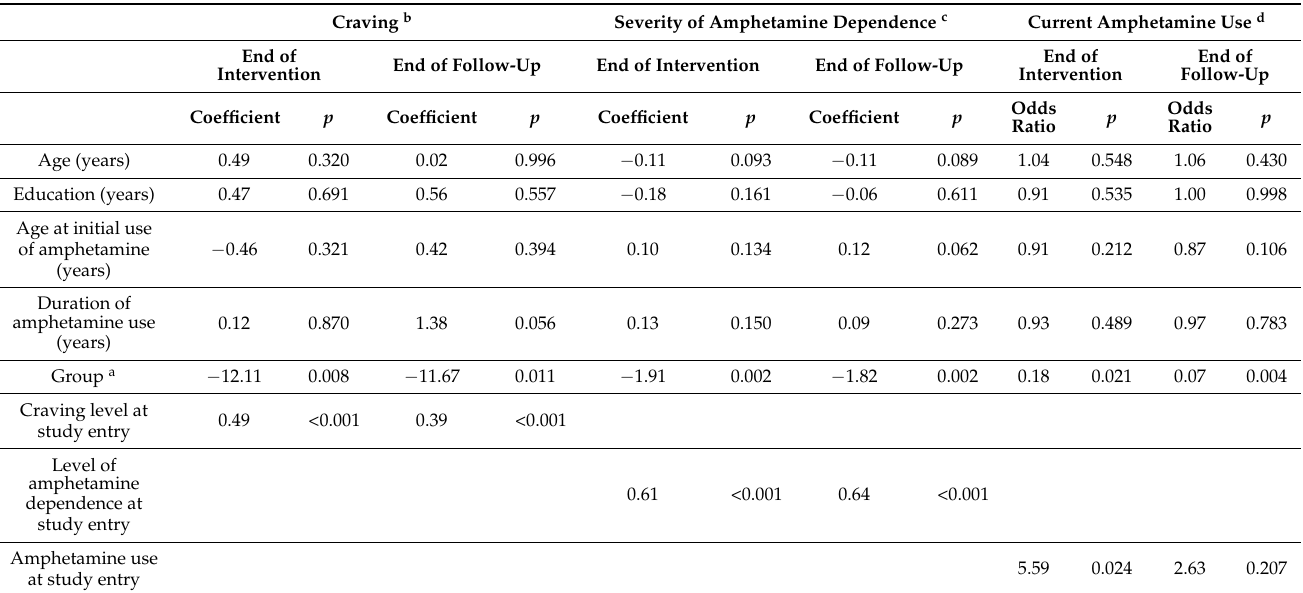
Table 4. Predictors of level of craving, severity of amphetamine dependence, and amphetamine use after the HRVBFB intervention and at the end of follow-up. Severity of Amphetamine Dependence